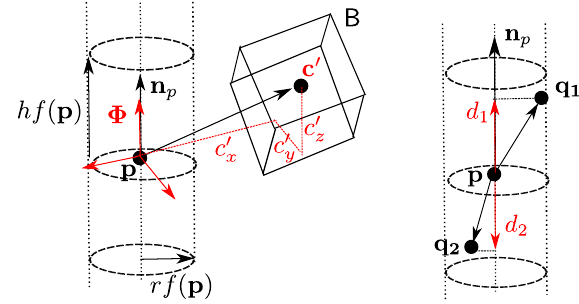
Figure 3: Left: Evaluation of the criterion describing if an octree box contains any points inside a specified cylinder p , n p , hf ( p ) , rf ( p ) . Conditions are based on the coordinates c ′ c ′ c ′ x , y , z of box center c ′ defined w.r.t. the coordinate system Φ . Right: Median filtering along the main filter direction n p . Translations induced by candidates q are given by their projection on the cylinder ∈ Q axis n p